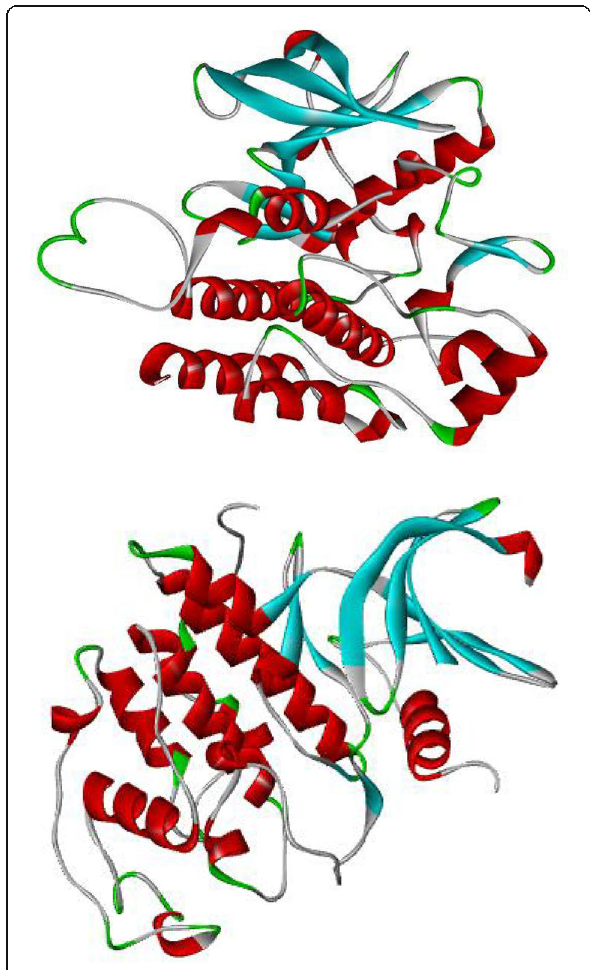
Plate 1 Crystal structure of CDK2 enzyme (PDB ID: